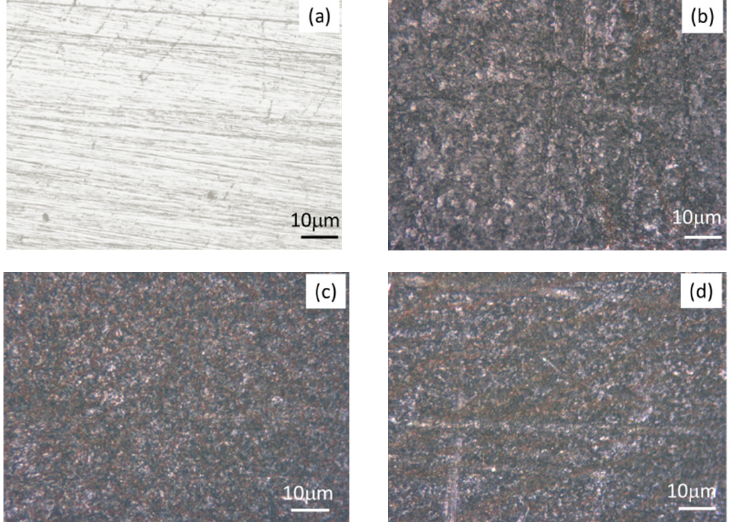
Figure 16. The MS surface images ( a ) polished surface before immersion, ( b ) after 1 h dipping in acid at 25 ° C, ( c ) after 1 h dipping in AV inhibitor at 25 ° C, and ( d ) after 1 h dipping in ST inhibitor solution at 25 ° C.